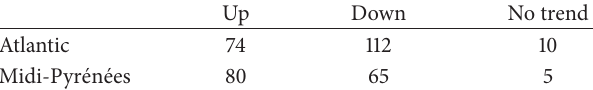
Table 2: Number of stations with positive and negative annual trends, and without trends.